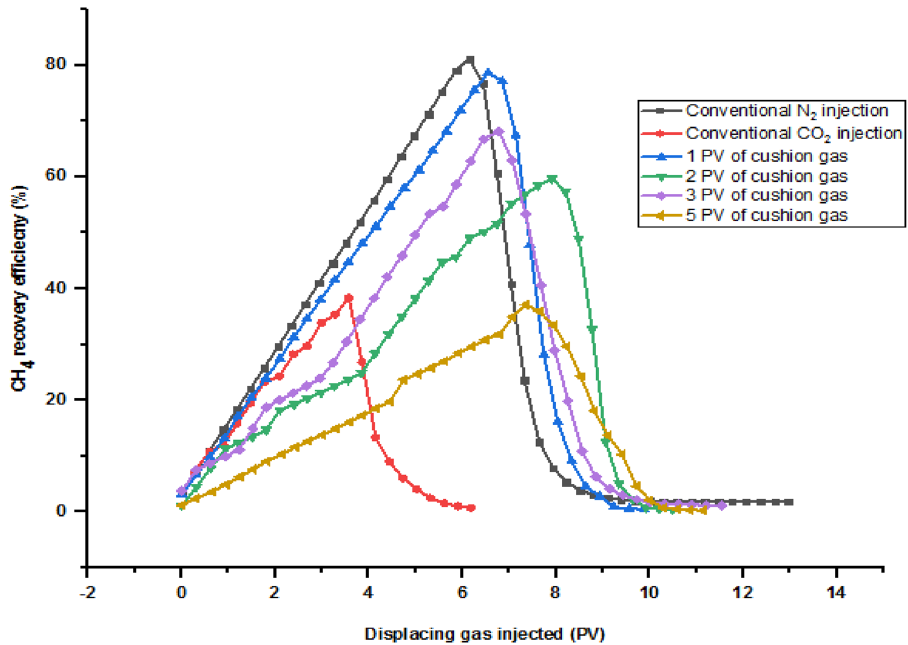
Fig. 14 Graphical representa- tion of percent CH 4 volume produced from all the experi- mental runs